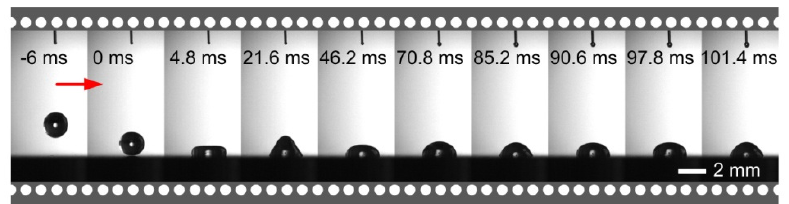
Figure 7. The bouncing process of water droplets on the polished aluminum alloy surface.